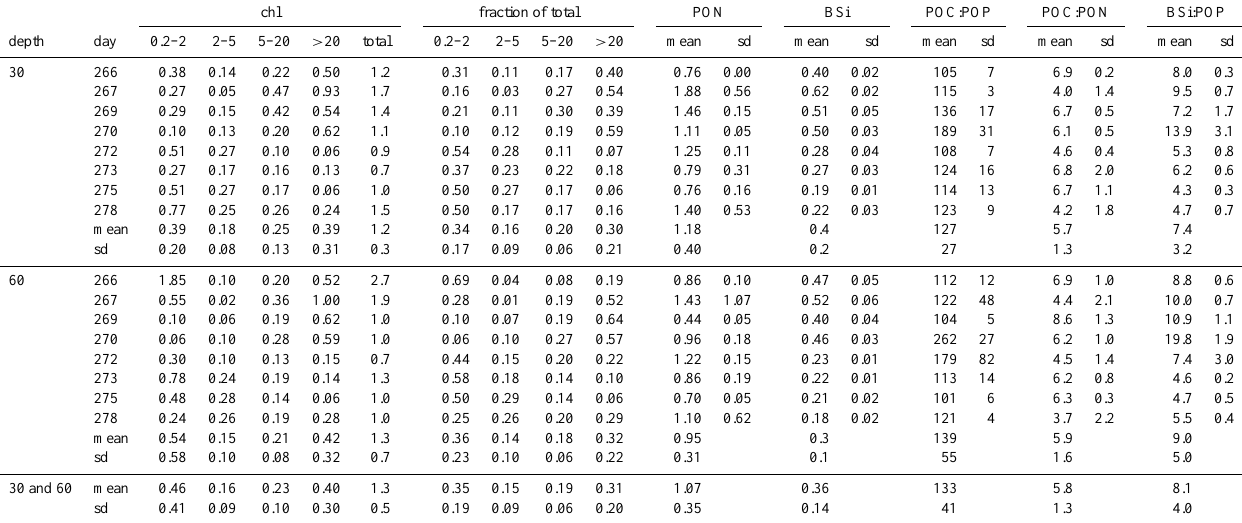
Table 2. Total and size fraction chl (µgchll − 1 ), chl size frequency distribution (fraction of total), total non-oxalate washed µM PON, µm BSi, and molar ratios of POC:POP, POC:PON, and BSi:POP for 30 and 60m (mean ± 1 standard deviation; n = 3). Size fractions consisted of 0.2–2µm, 2–5µm, 5–20µm, and > 20µm; total represents the sum of all size fractions ( > 0.2µm).